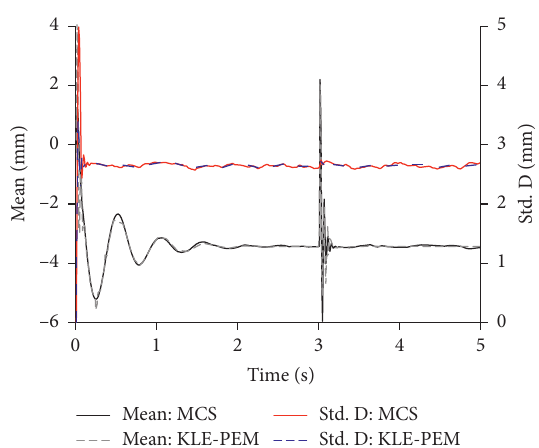
Figure 3: Comparison of displacement of the wheel. Table 2: Properties of train.